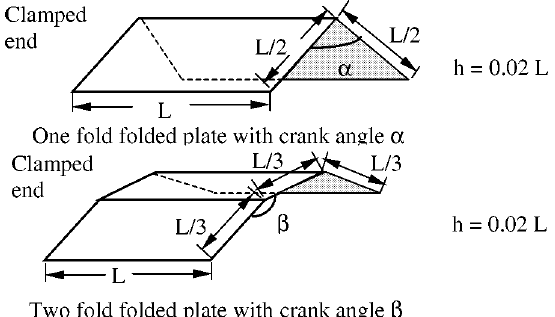
Fig. 3. Geometry of the folded plate used in examples 1, 2, 4, 5 and